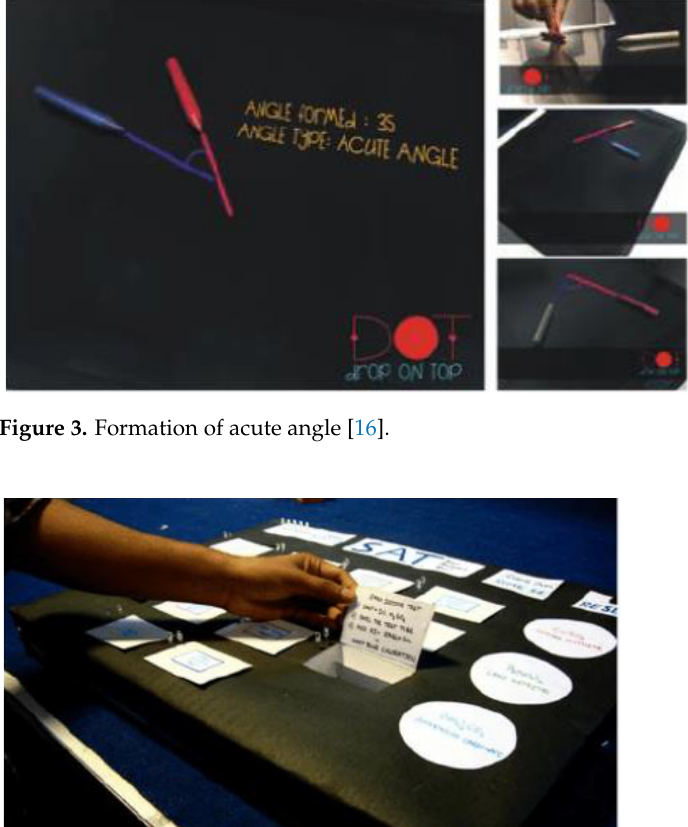
Sensors 2021 , 21 , x FOR PEER REVIEW Figure 4. Salt Analysis — student presents reaction details [16]. Figure 4. Salt Analysis—student presents reaction details [16].